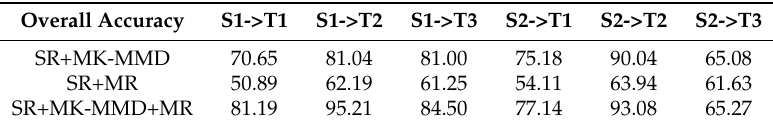
Table 3. The overall accuracy (percent) improvements with different combination of regularization across six pairing of the transfer